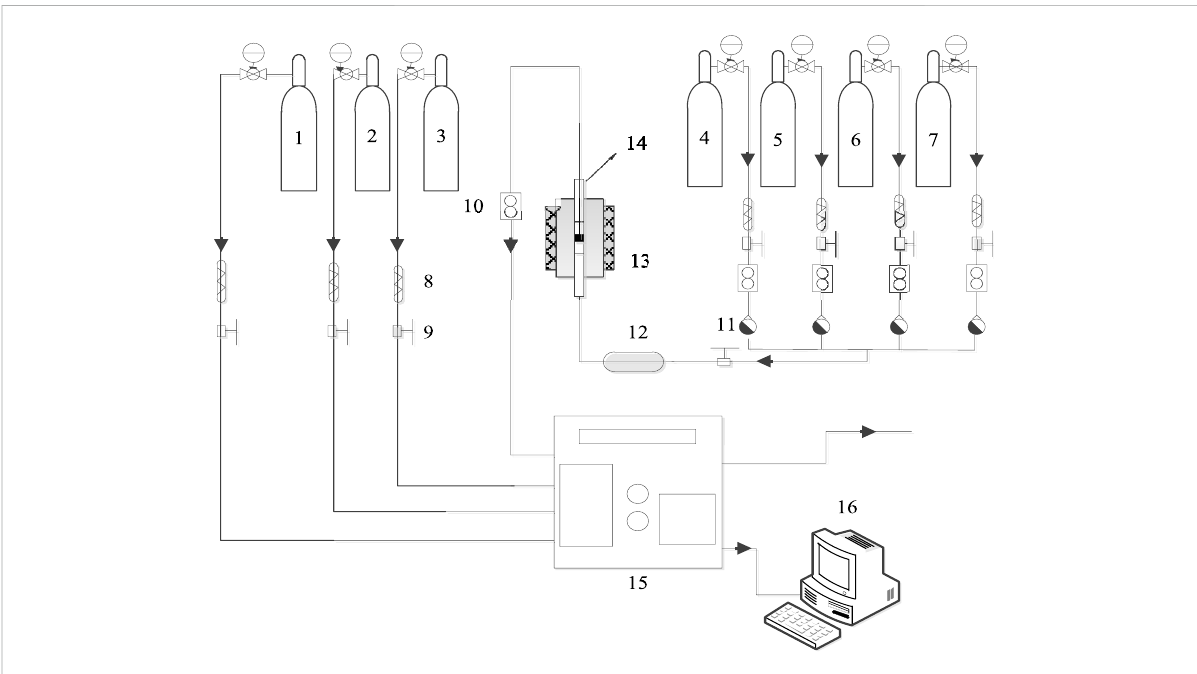
FIGURE 1 Equipment diagram for the evaluation of theactivity of the NH 3 -SCR catalyst. 1. Nitric oxide. 2. Ammonia. 3. Nitrogen. 4. Oxygen. 5. Propane. 7. Other Gases. 8. Filter. 9. Globe valve. 10. Mass fl owmeter. 11. One-way valve. 12. Mixer. 13. Heating furnace. 14. Reactor. 15. Gas analyzer. 16.